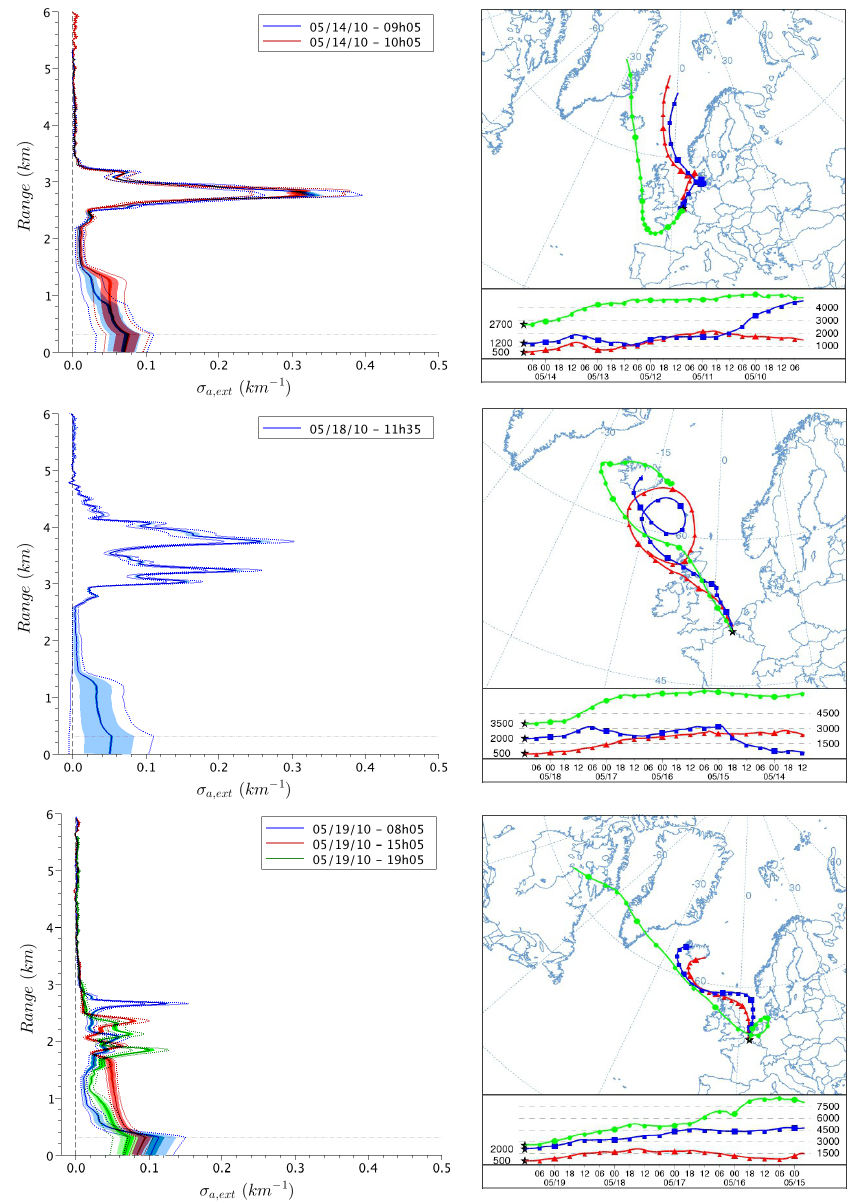
Fig. 7. Retrieved extinction profiles and corresponding backward trajectories for 14, 18, and 19 May 2010.